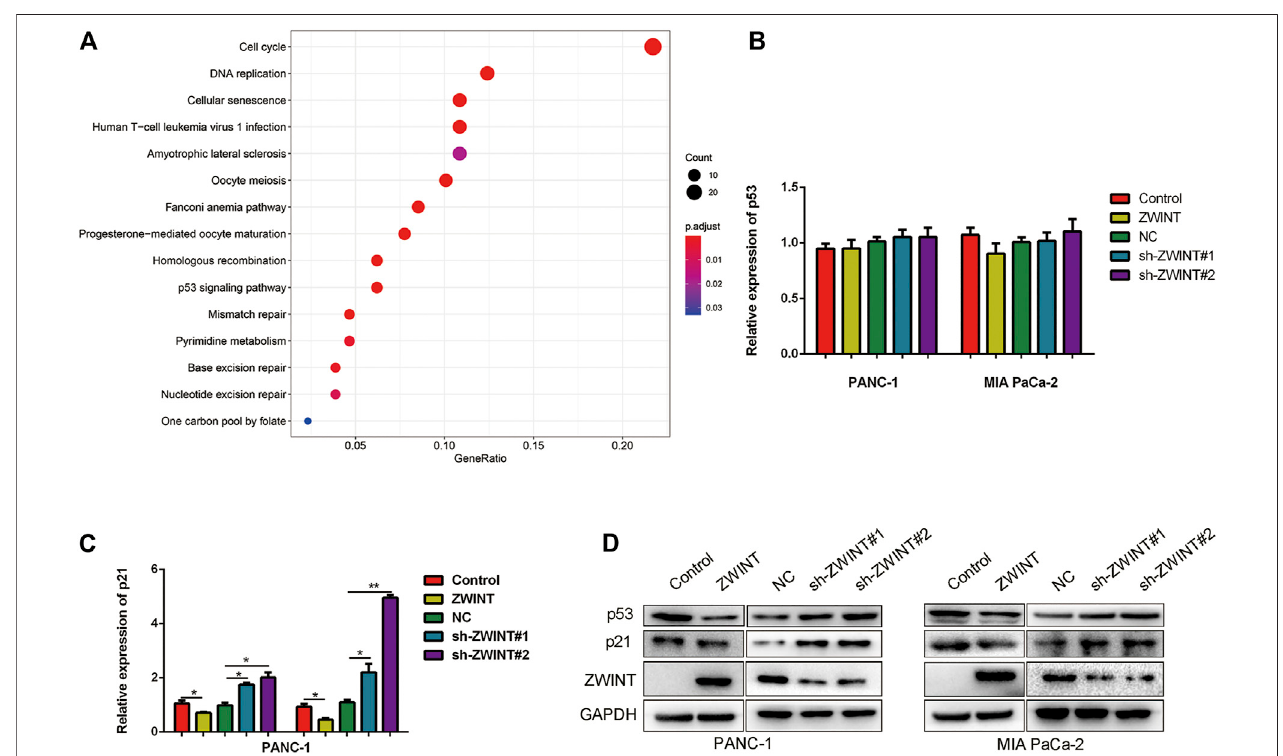
FIGURE4| ZWINT interacted and regulated p53/p21 signal pathway. (A) Bioinformatic analysisthedownstreampathway ofZWINT basedon theTCGA databse. (B, C) q-RT-PCR and western blot analysis the expression of p53 and p21 in mRNA level. (D) Western blot analysis the expression of p53 and p21 in protein level.